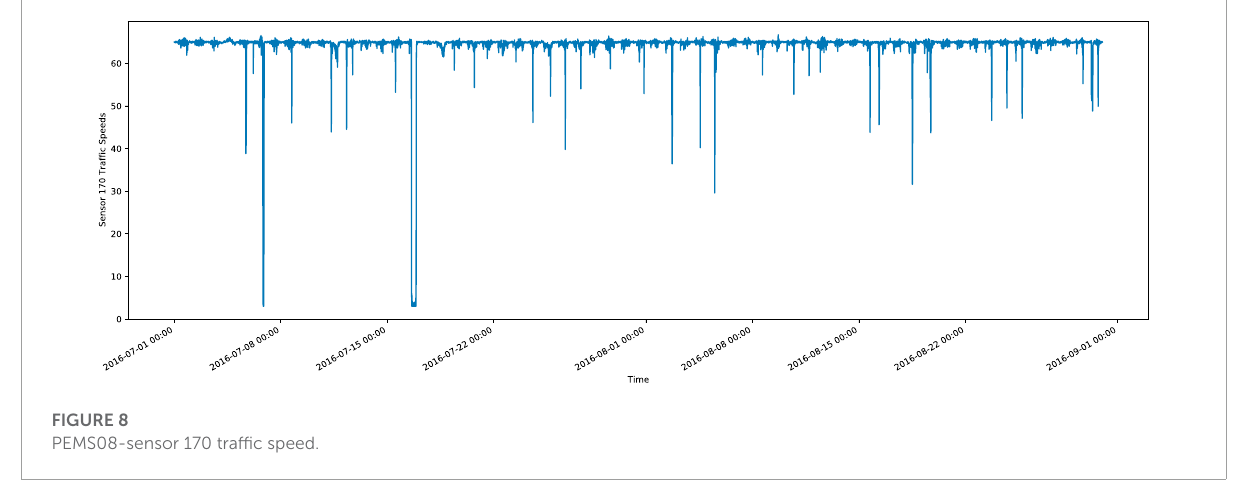
FIGURE 8 PEMS08-sensor 170 traffic speed.